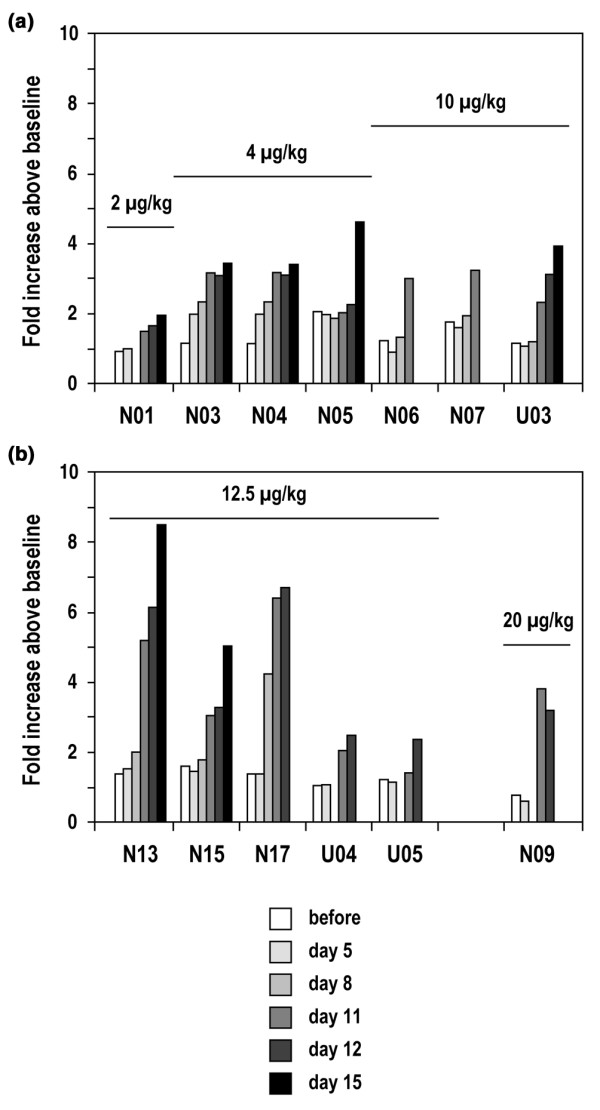
Development of scFv(FRP5)-ETA-specific antibodies after treatment. Relative levels of scFv(FRP5)-ETA-specific antibodies induced in patients by the treatment were determined by ELISA with plates coated with the antibody toxin. Sera taken on day 0 before treatment, and sera taken at the indicated days after onset of therapy were diluted 1:50 for analysis. The baseline was determined using several human control sera negative for scFv(FRP5)-ETA-specific antibodies (not shown). Dose levels and patients are indicated.